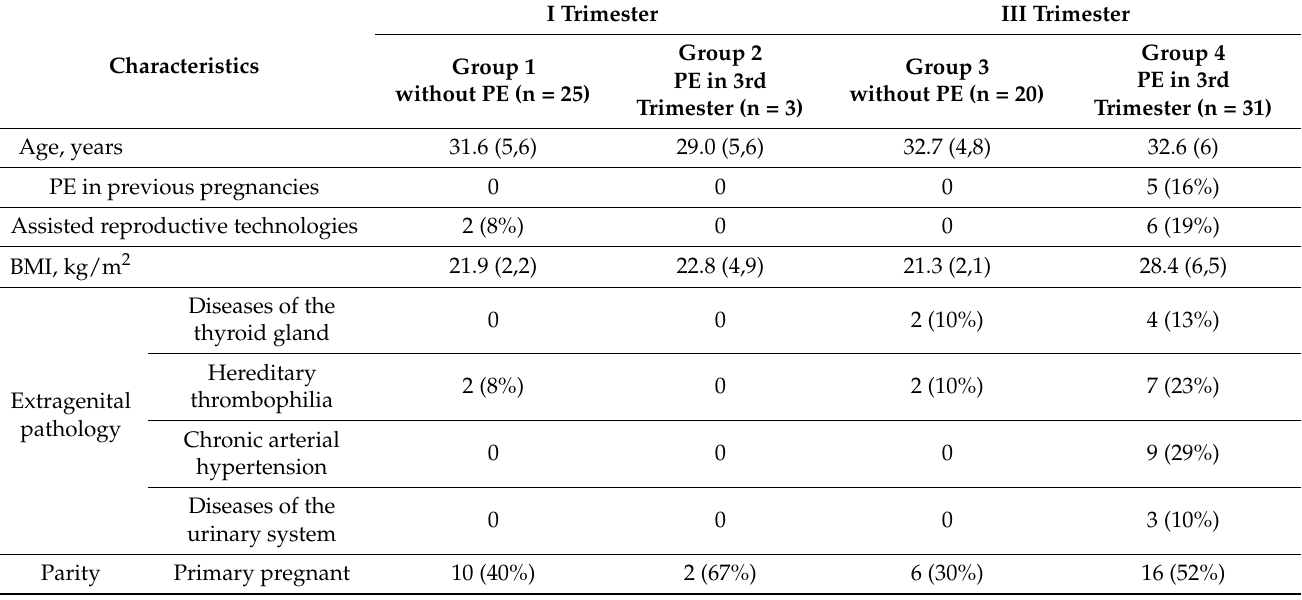
Table 1. Demography of the